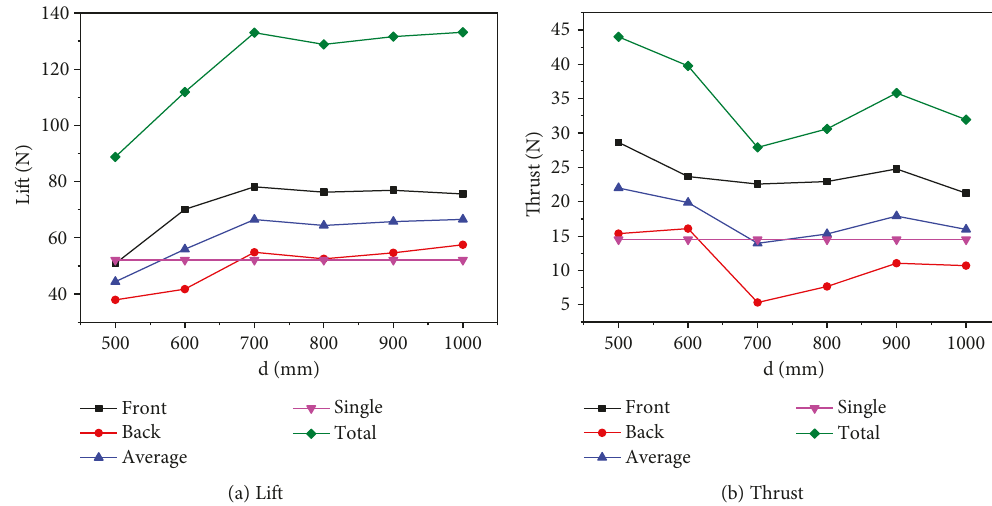
Figure 6: Tandem fan wing aerodynamic force with the changing curve following the distance between the front and rear wings.